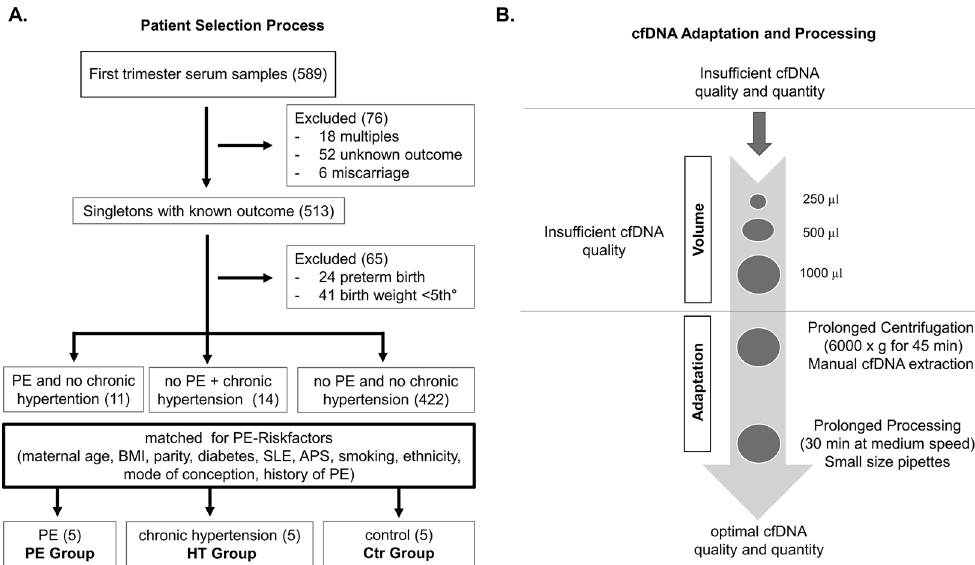
Figure 1. Patient and sample selection process. ( A ) Flowchart summarizing the selection process resulting in the final groups. ( B ) Flowchart summarizing the adaptation process to generate cfDNA of sufficient quality and quality. Sufficient cfDNA quality was assessed using the presence of the mono-nucleosome fragment around 170 bp, a di-nucleosome fragment around 350 bp, and a tri-nucleosome fragment between 550 to 580 bp. Preeclampsia (PE); Systemic Lupus erythematosus (SLE); Antiphospholipid Syndrome